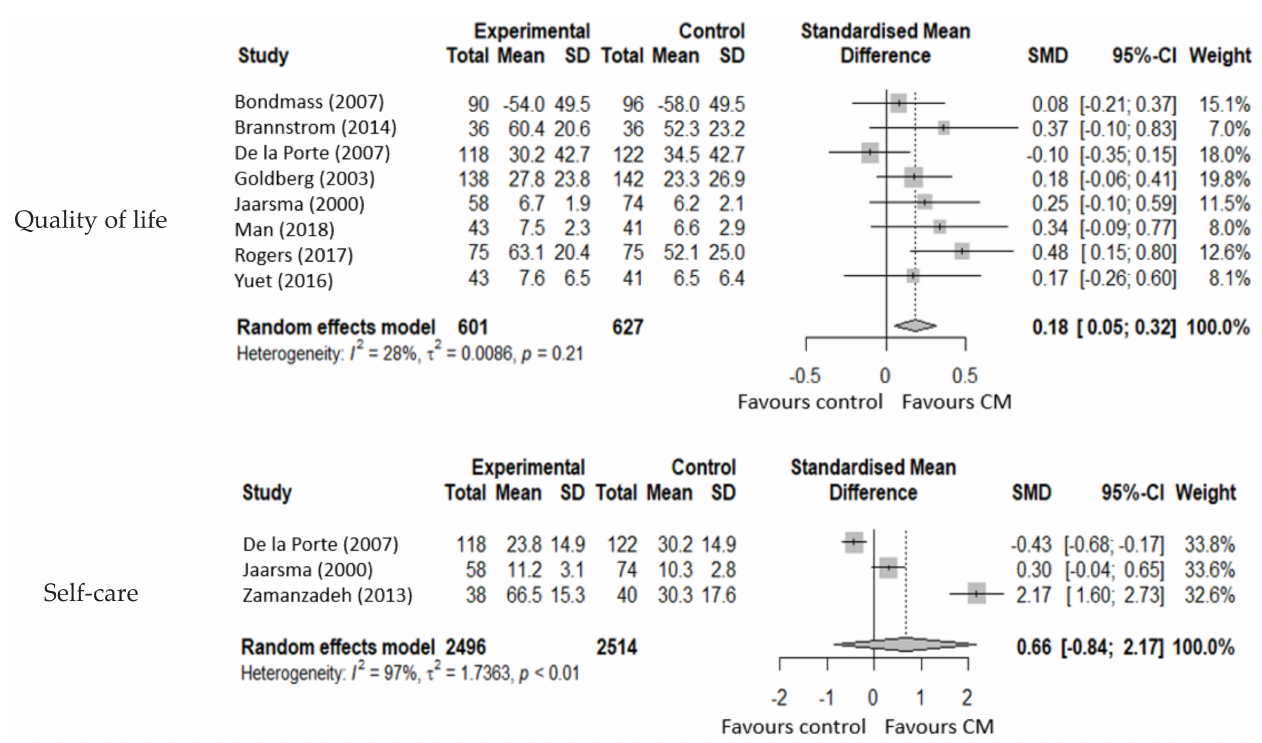
Figure 2. Metanalysis for all-cause mortality, hospitalizations for heart failure, all-cause hospitaliza- tions, quality of life, and self-care. CM: nurse-led case